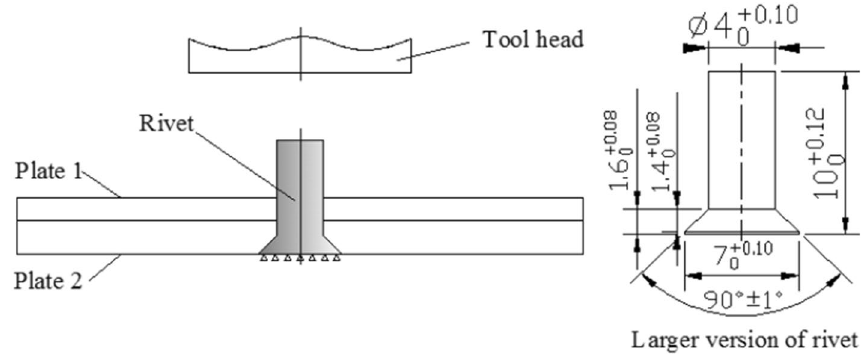
Figure 2. Riveting structure and the size of rivet.